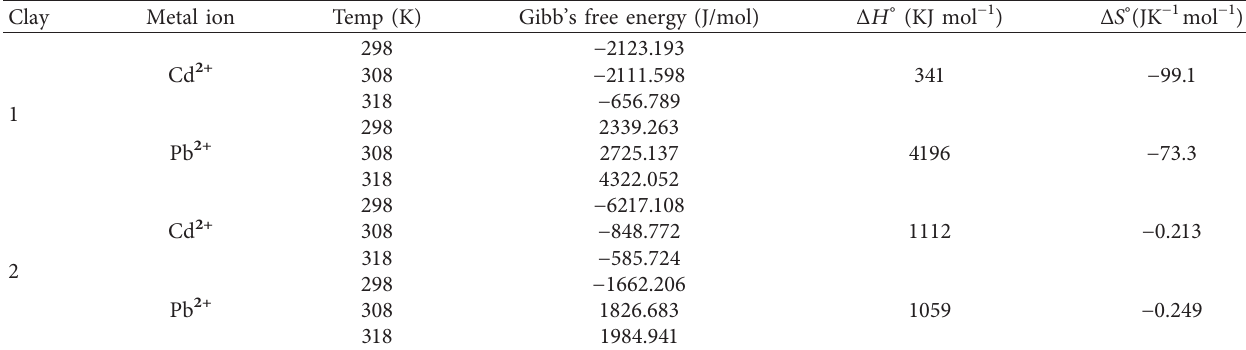
Table 2: Adsorption thermodynamics parameters for the adsorption of Cd 2+ and Pb 2+ by clay-1 and clay-2.